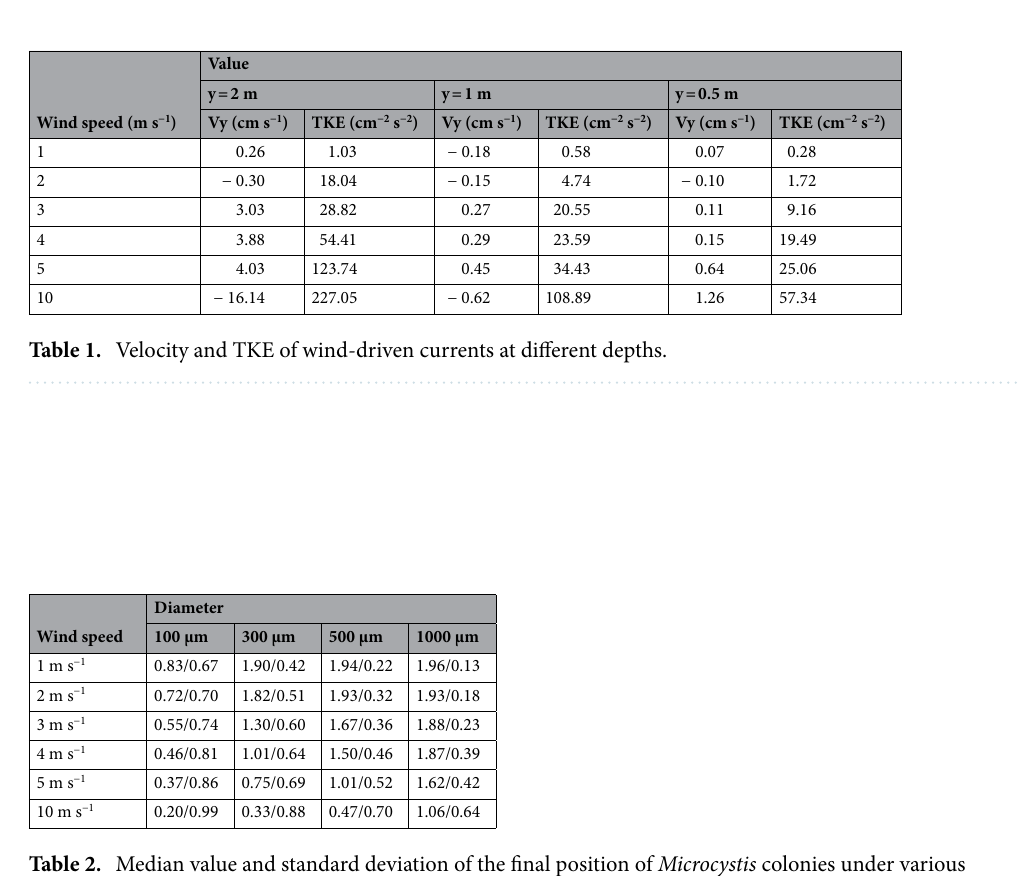
Table 2. Median value and standard deviation of the final position of Microcystis colonies under various constant wind speeds. Median value/standard deviation (unit: m).